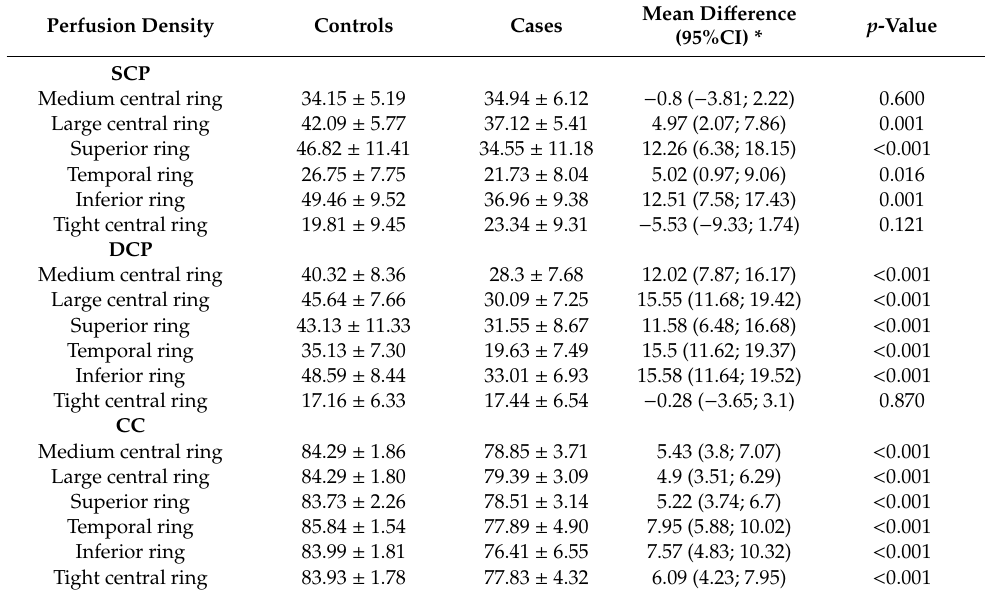
Table 4. Perfusion Density values in cases and controls.